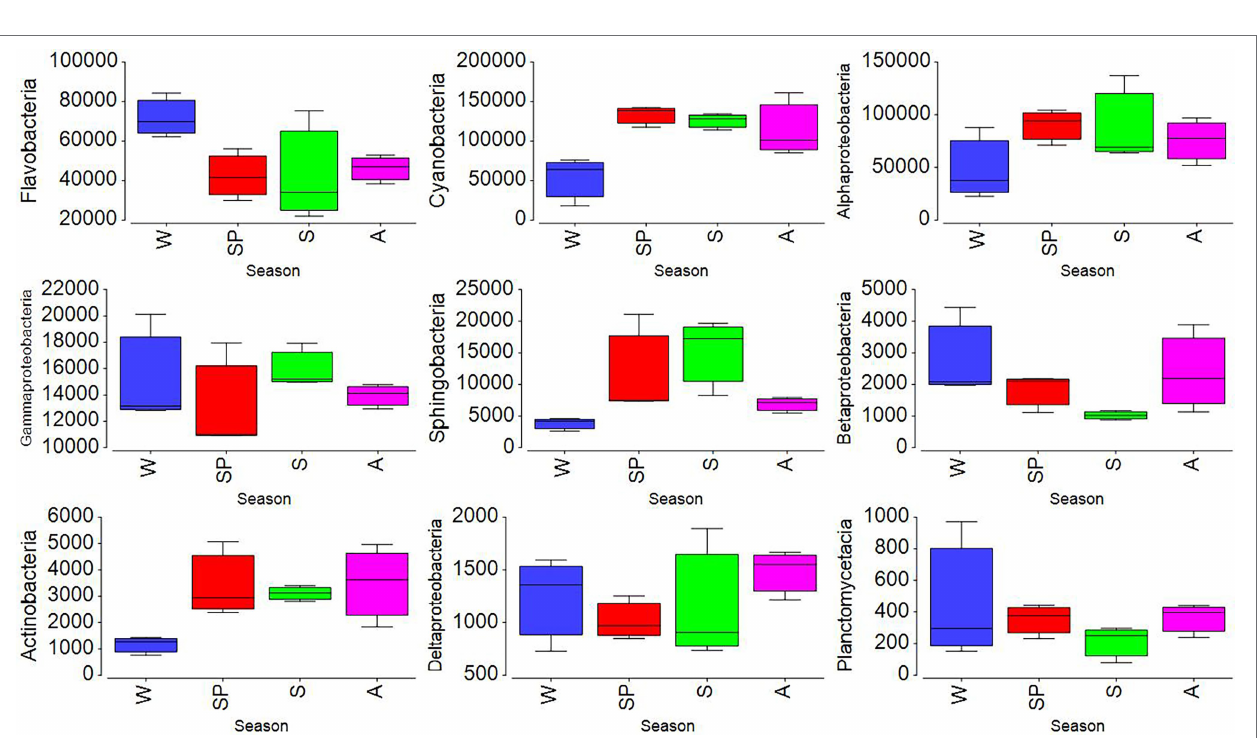
FIGURE 3 | Heat map displaying the relative abundances (color code represents the percent relative abundances) and distribution of highly represented bacterial taxa at the class level at the coastal site of the Red Sea.